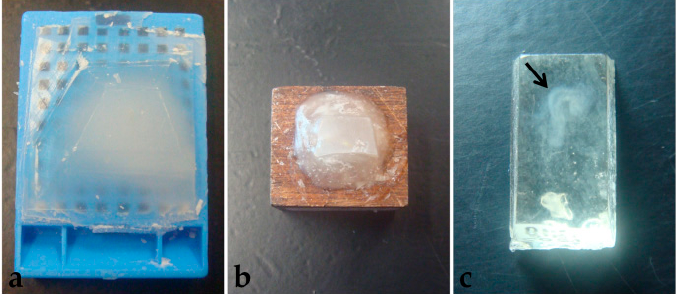
Figure 8. Polymerized blocks. ( a ) Paraplast. ( b ) PEG. ( c ) Historesin. Arrow: Embryo. H&E staining provided an appropriate contrast between the nucleus and cytoplasm.